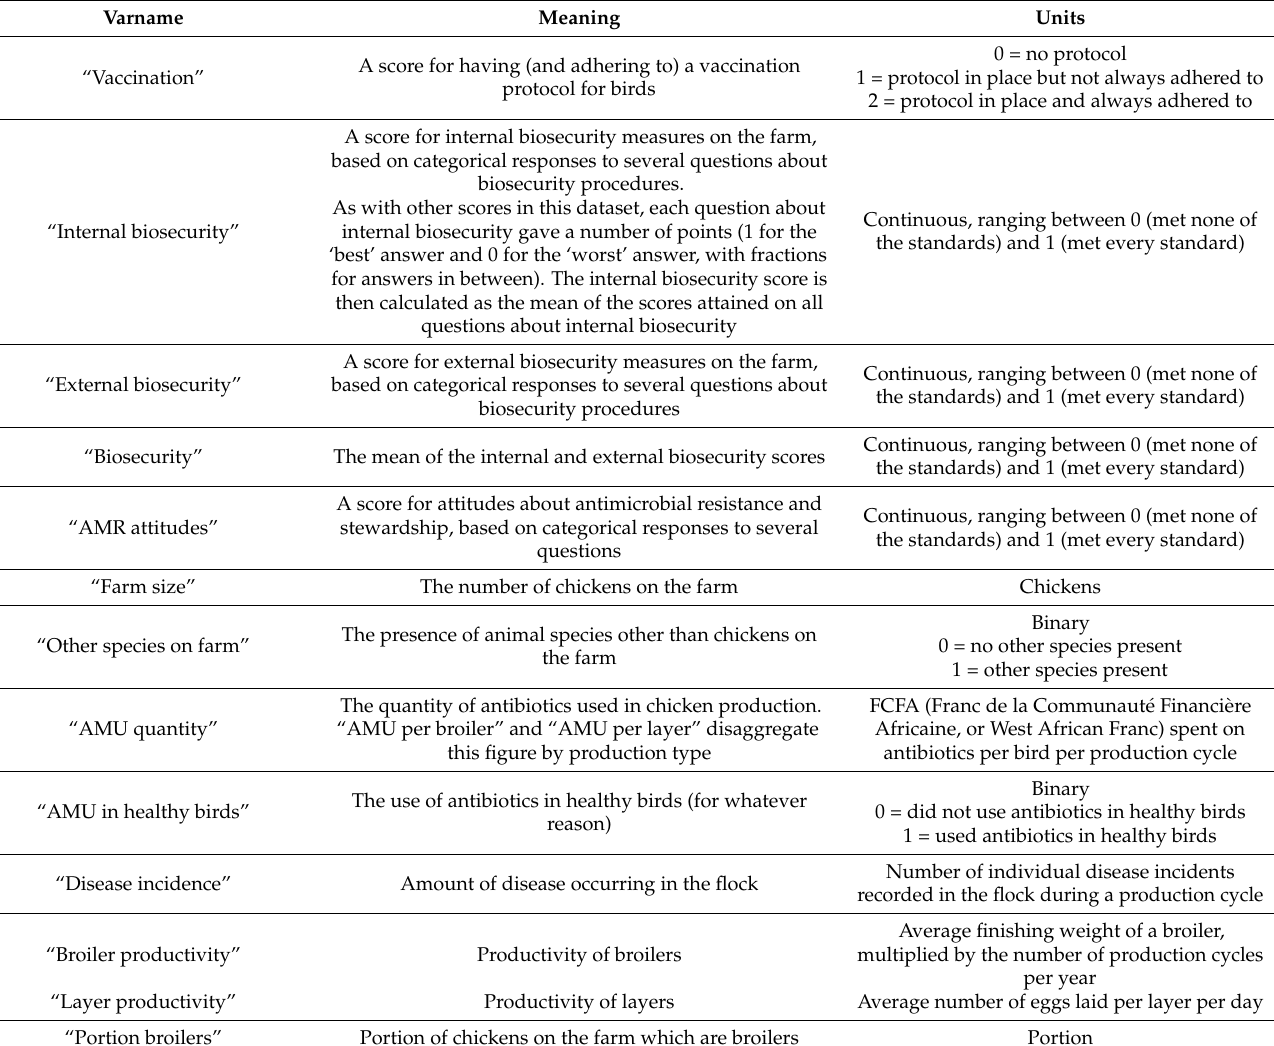
Table 7. Variable